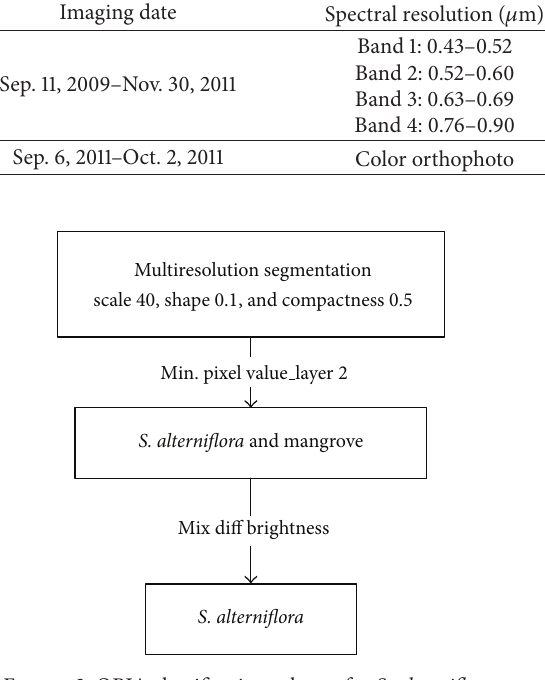
Figure 2: OBIA classification scheme for S.